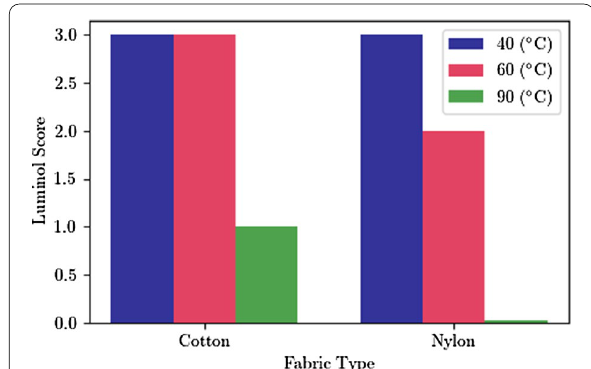
Fig. 3 Luminol score for bloodstains washed at 40, 60 and 90 °C